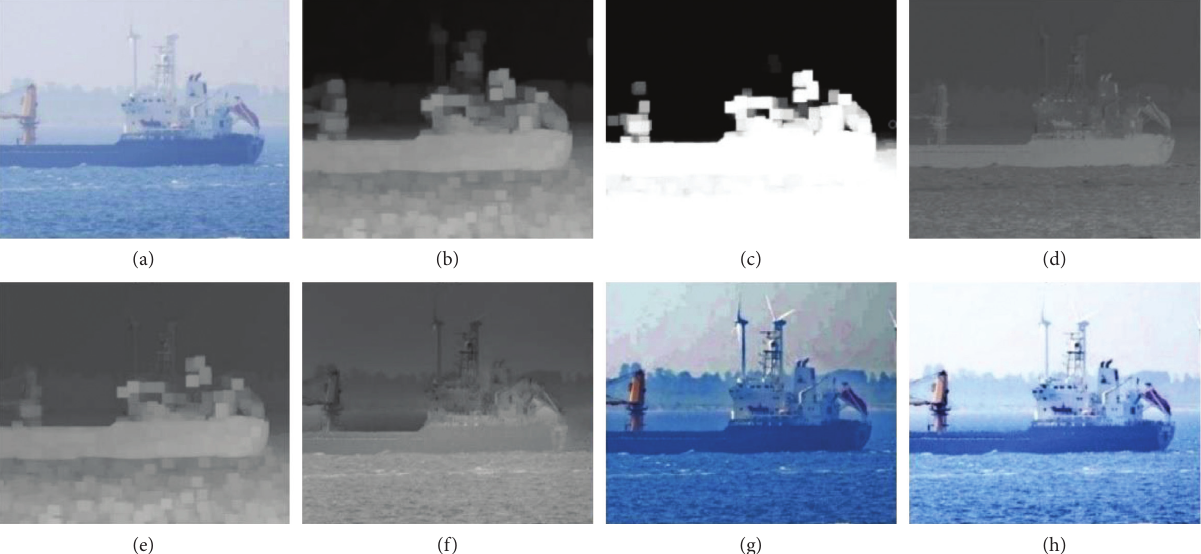
Figure 4: Our dehazing framework. From top-left to bottom-right: (a) input hazy image, (b) DCP-based transmission map 􏽥 t map of transmission, (d) luminance-based transmission map 􏽥 t L ( x ) , (e) initial transmission 􏽥 t result with 􏽥 t d , and (h) dehazing result with t ∗